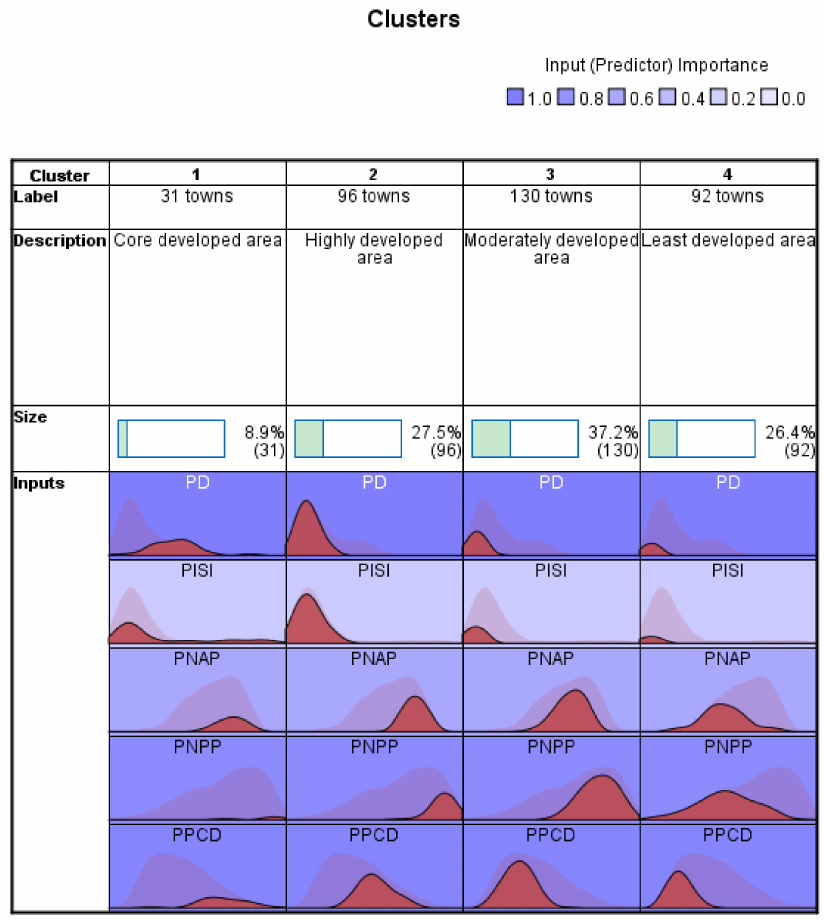
Figure 9. Two-step cluster analysis